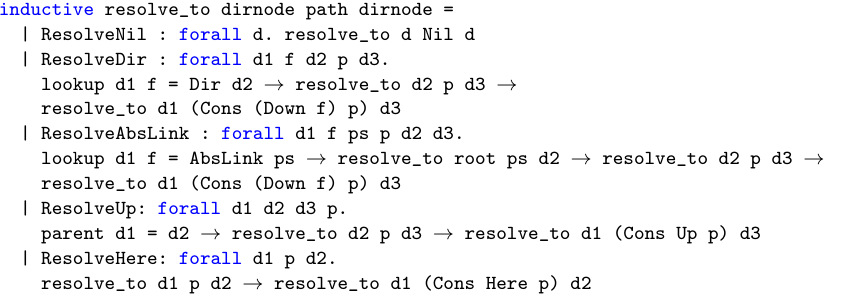
Journal of Formalized Reasoning Vol.10,